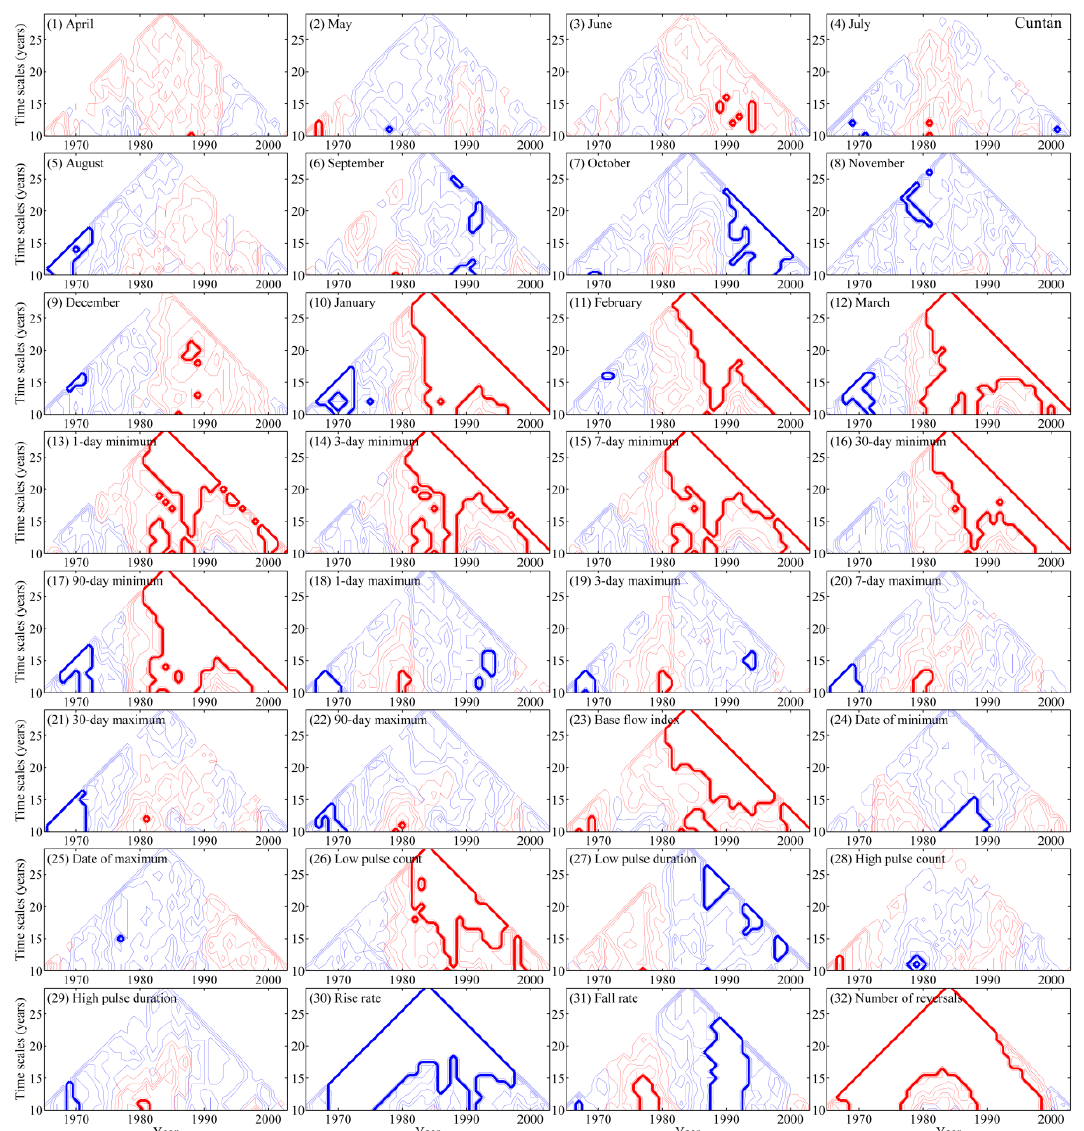
Figure 3. Change points on different time scales of the hydrologic regime at the Cuntan station.